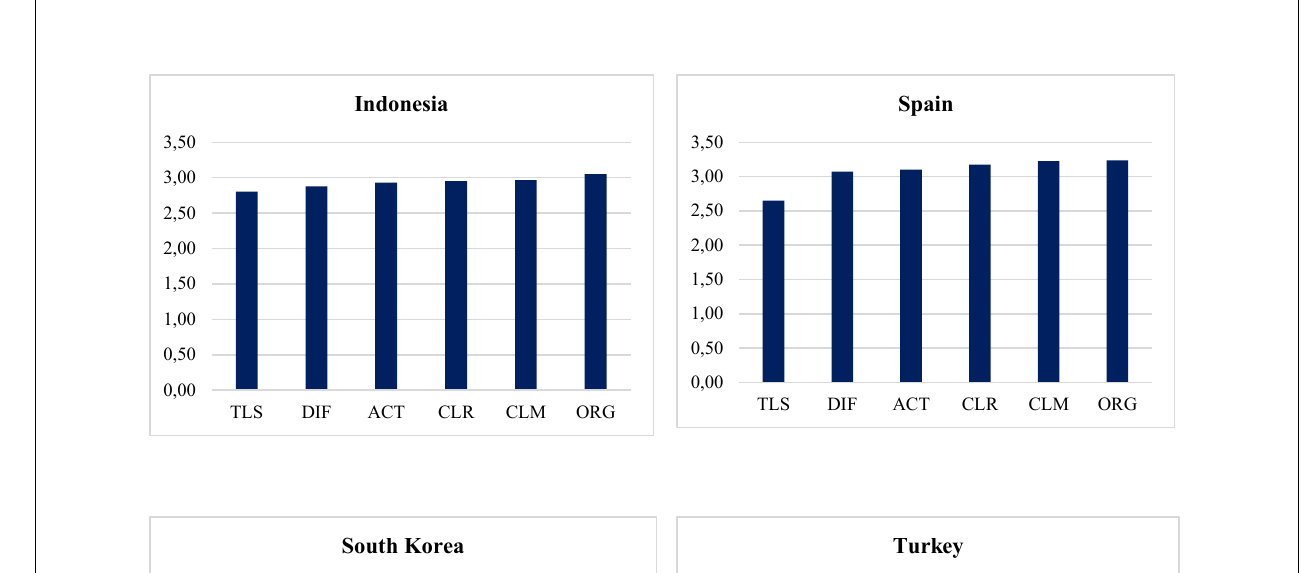
to compare perceived teaching behavior across countries based on a uniform student